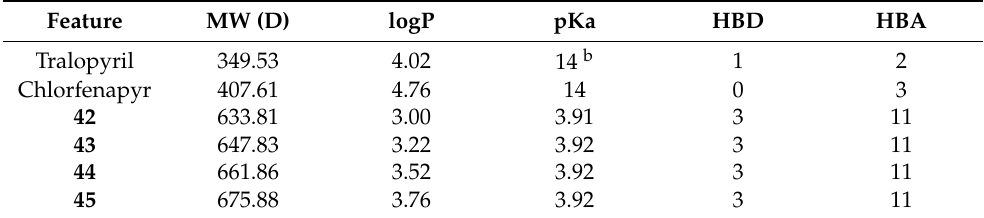
Table 4. Predicted physicochemical descriptor MW, logP, pKa, HBD, HBA of tralopyril, chlorfenapyr, 42 , 43 , 44 , and 45 a .